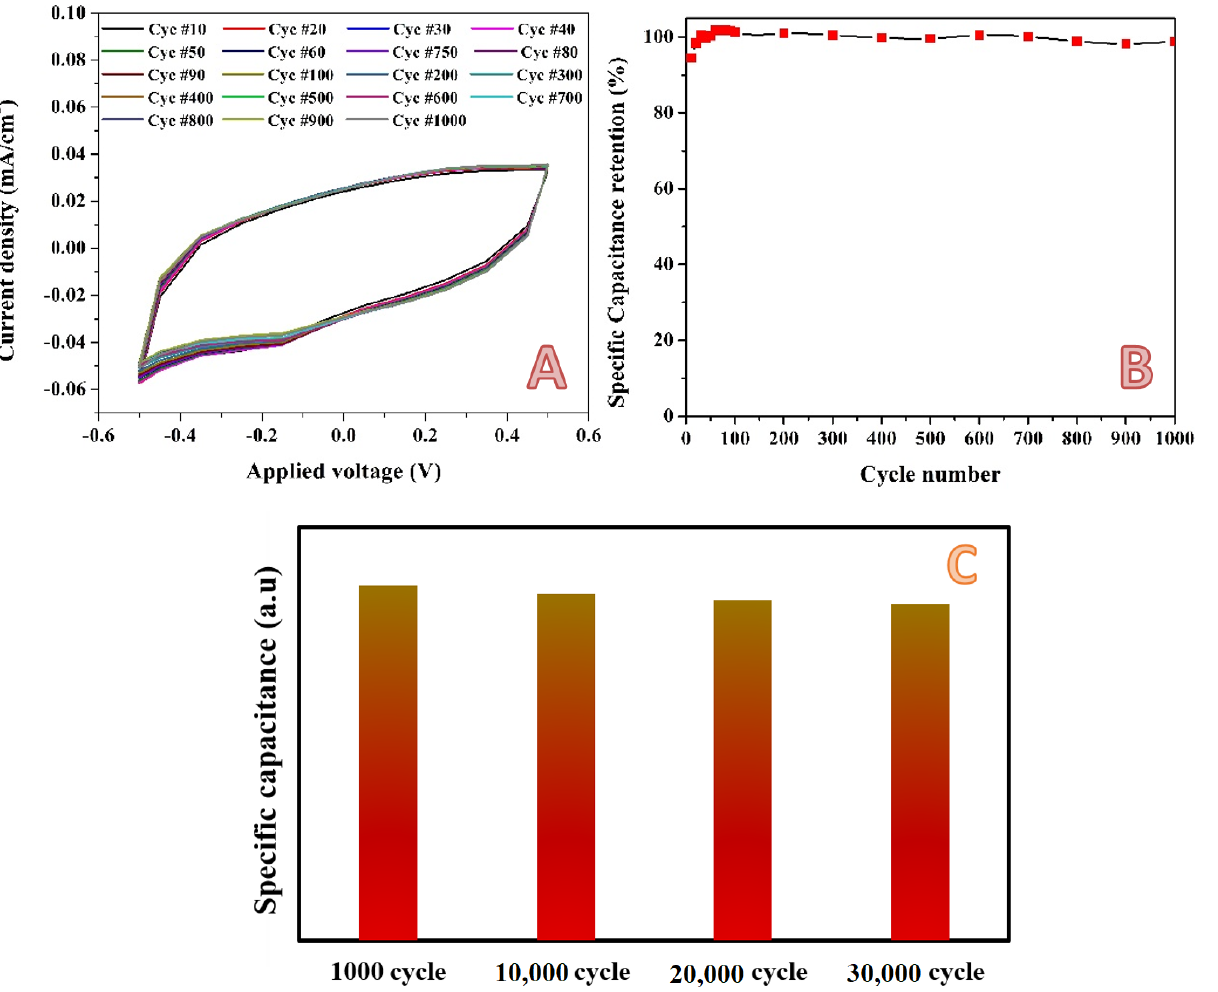
Figure 12. Cyclic voltammetry (selected cycles from 1000 cycles) for the electrode obtained from activation using H 3 PO 4 /KOH combined solution (14 mL) in 0.1 M H 2 SO 4 at scan rate 2 mV/s and 25 °C; ( A ), and specific capacitance retention; ( B ). Panel ( C ) displays the specific capacitance retention after 30,000 cycles within a potential window of − 0.2 to 0.2 V (vs. Ag/AgCl) at a scan rate of 10 mV/s using 0.1 M H 2 SO 4 electrolyte.